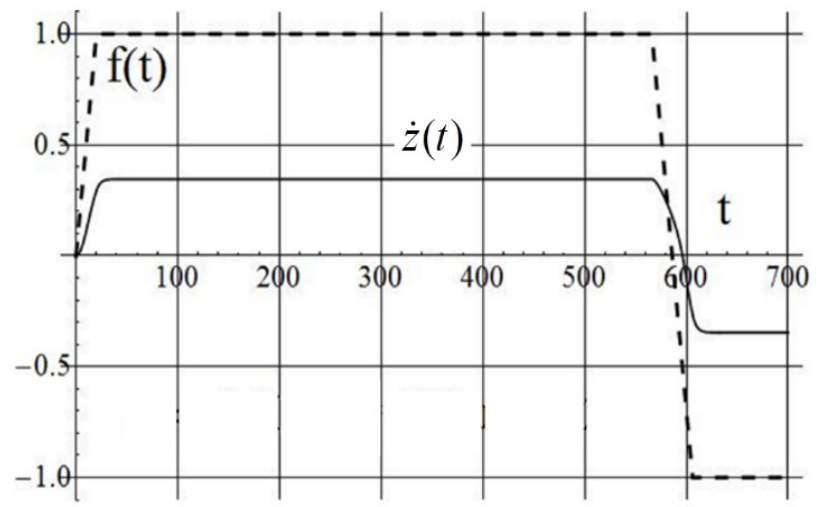
Figure 14. Speed of submergence of the cylinder versus time for l c = 1 m, H = 200 m, η = 0.005, t 0 = 20 c